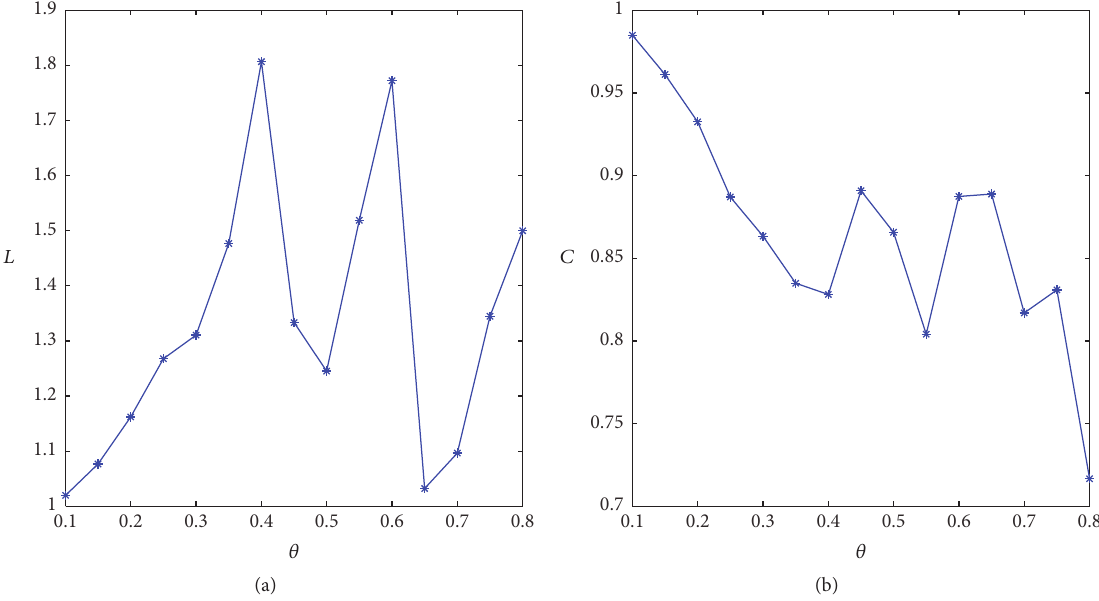
Figure 3: The average path length 𝐿 and clustering coefficient 𝐶 versus 𝜃 .